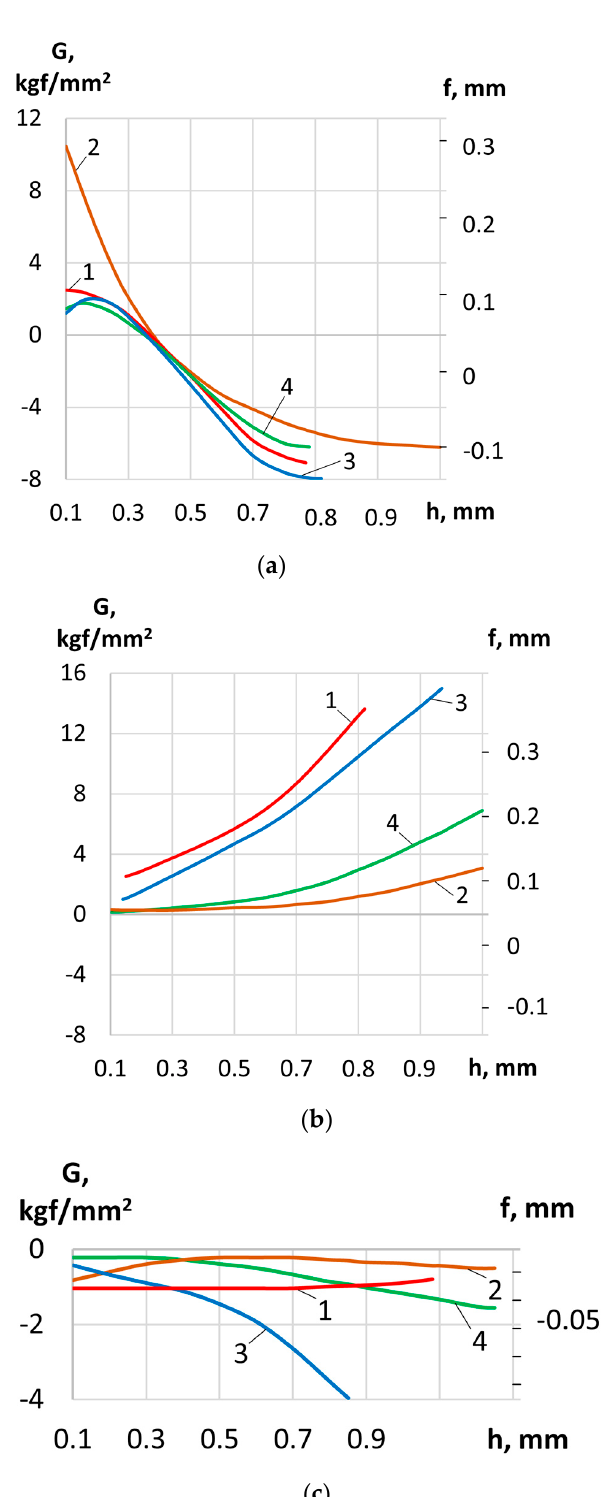
Figure 3. Investigation of changes in residual voltage by the bend of the carbon steel sample under study, depending on the thickness h of the coating material: ( a )—molybdenum coating; ( b )—nickel coating; ( c )—zirconium dioxide coating. 1—residual voltage (during plasma spraying); 2—voltage (laser spraying Ni +ZrO 2 ); 3—deflection (arc surfacing); 4—deflection (flame spraying).